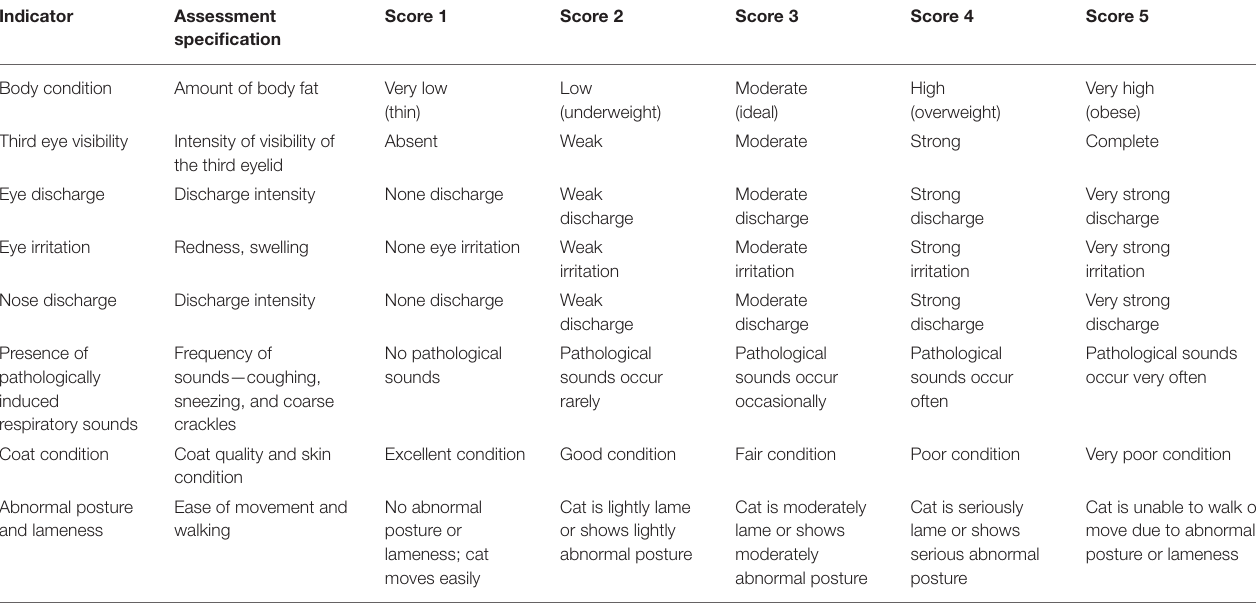
TABLE 1 | Assessment protocol—description of scores in individual indicators.